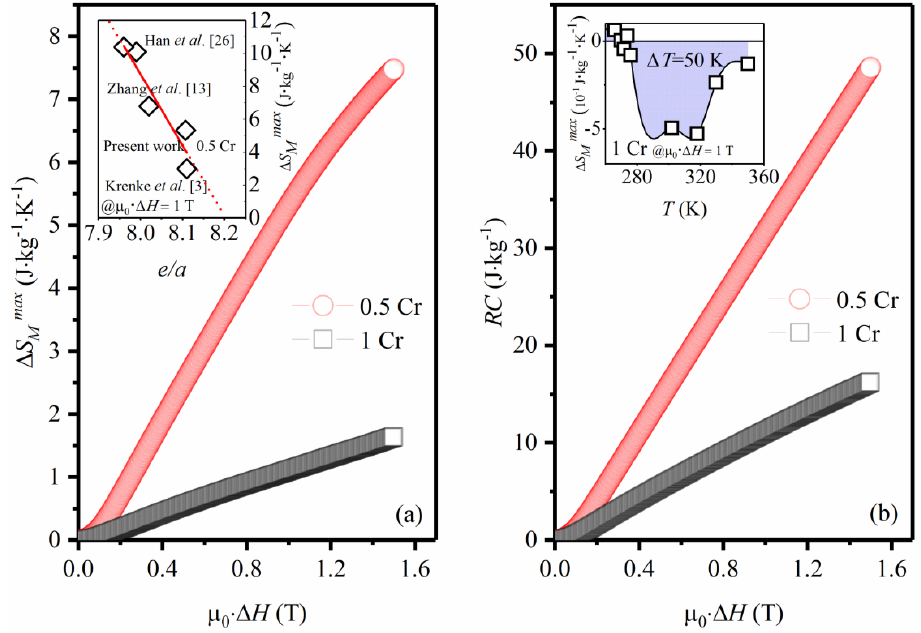
Figure 7. Magnetic field dependence of Δ S M ma x and of calculated RC for the 0.5 Cr ( a ) and 1 Cr ( b ) alloys. Inset ( a ) shows Δ S M ma x vs. e/a for selected Ni–Mn–Sn alloys and presently studied 0.5 Cr alloy. Inset ( b ) gives Δ S M ma x vs. T dependence around T C A for the 1 Cr sample.